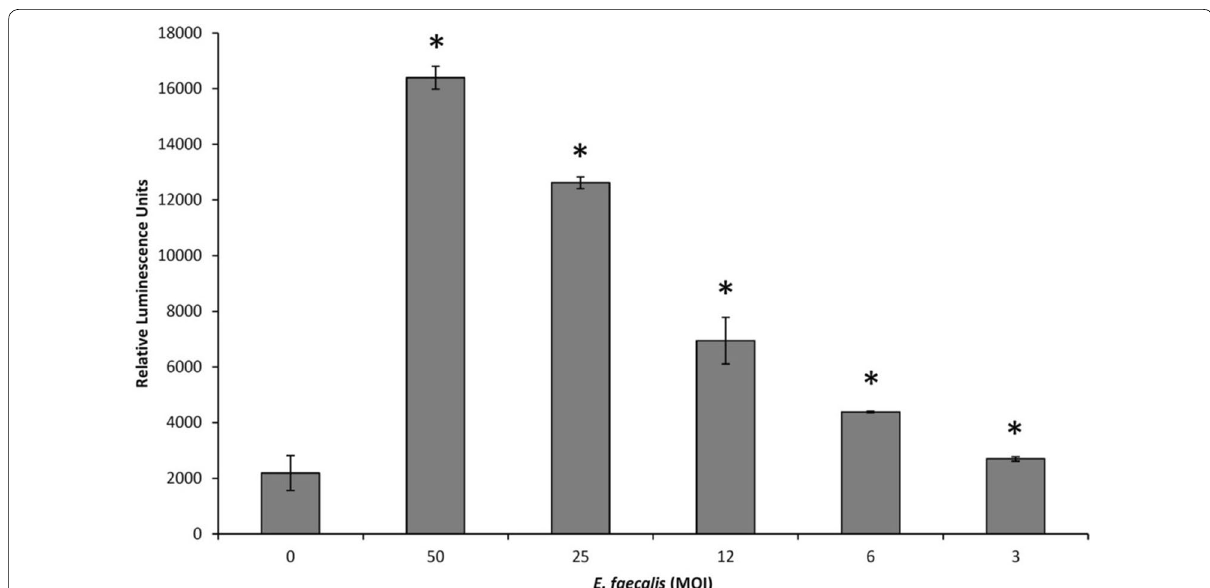
Fig. 1 Effects of E. faecalis ATCC 19433 on NF-κB activation using the human monoblastic leukemia cell line U937-3xκB-LUC. *Significant increase ( p < 0.01) compared to unstimulated control